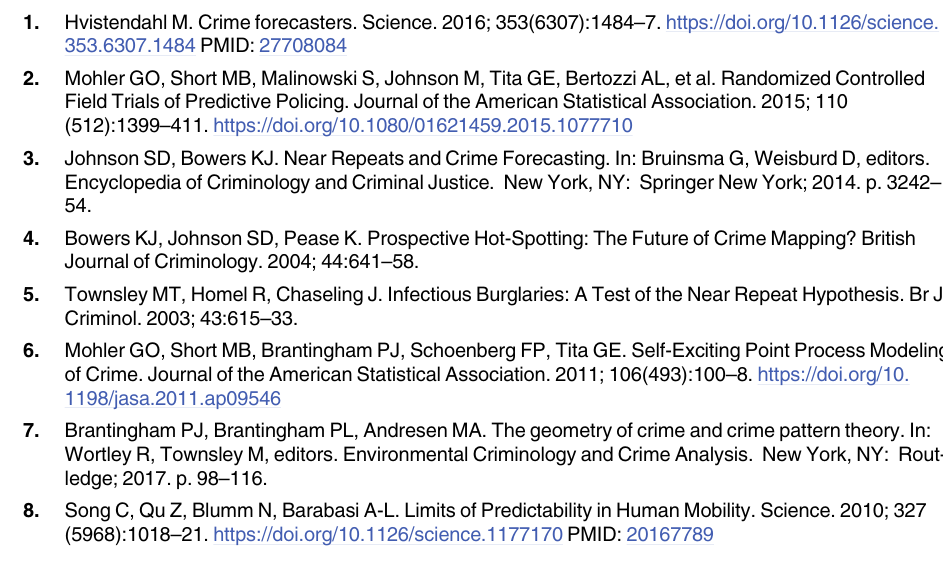
S15 Table. Conditional logit estimates of a parsimonious version of the model “+ opportu- nity”. Distance from activity space and distance from prior crime are measured as the contigu- ity order of a grid cell, with a maximum of 7 for any grid cells beyond 6th order contiguity, and 0 for grid cells inside activity space and grid cells were the offender committed a prior offense,